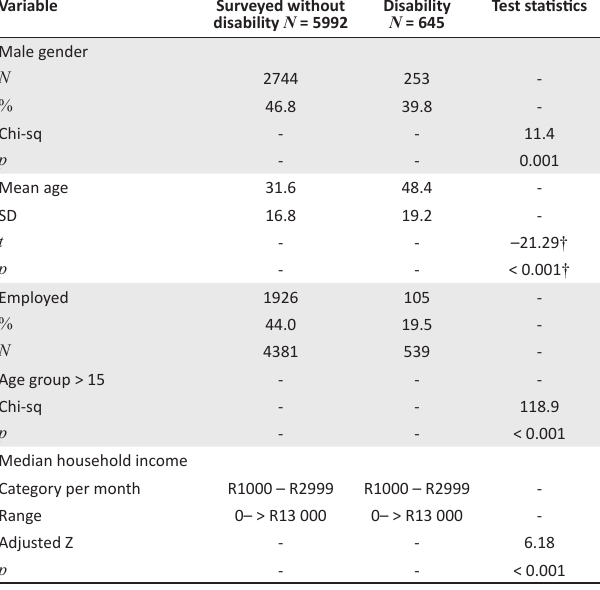
TABLE 3: Demographic information of those who screened positive for disability compared to those not reporting a disability ( N = 6637). Variable Surveyed without disability N = 5992